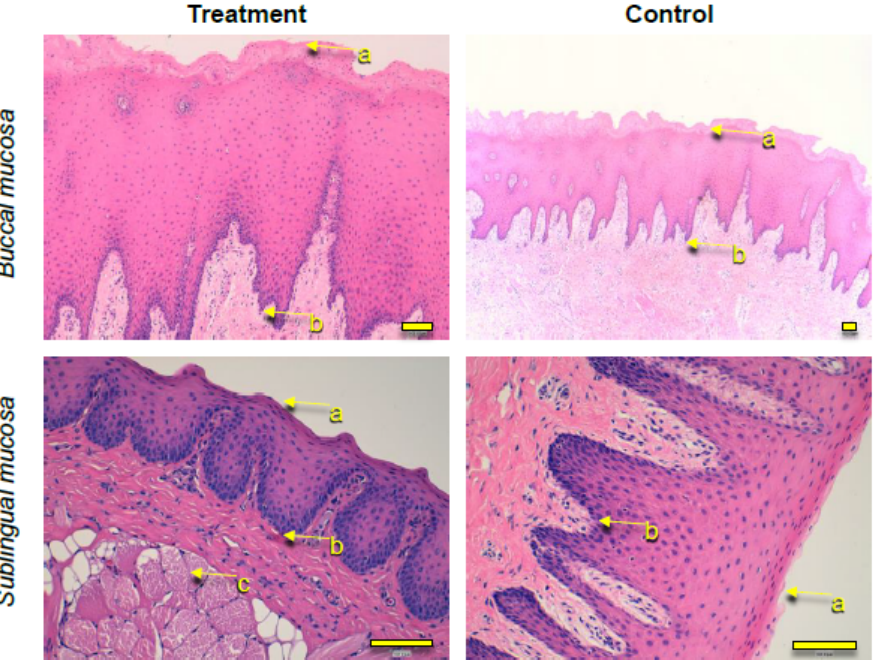
Figure 10. Histological observations of buccal ( top ) and sublingual ( bottom ) mucosas after application of the formulation 0.05% TA + LIDO ( left ). Untreated tissues were processed in parallel as a control ( right ). ( a ) Stratified flat keratinized epithelium, ( b ) basal layer ( c ) collagen fibers. Scalebar represents 100 µm.